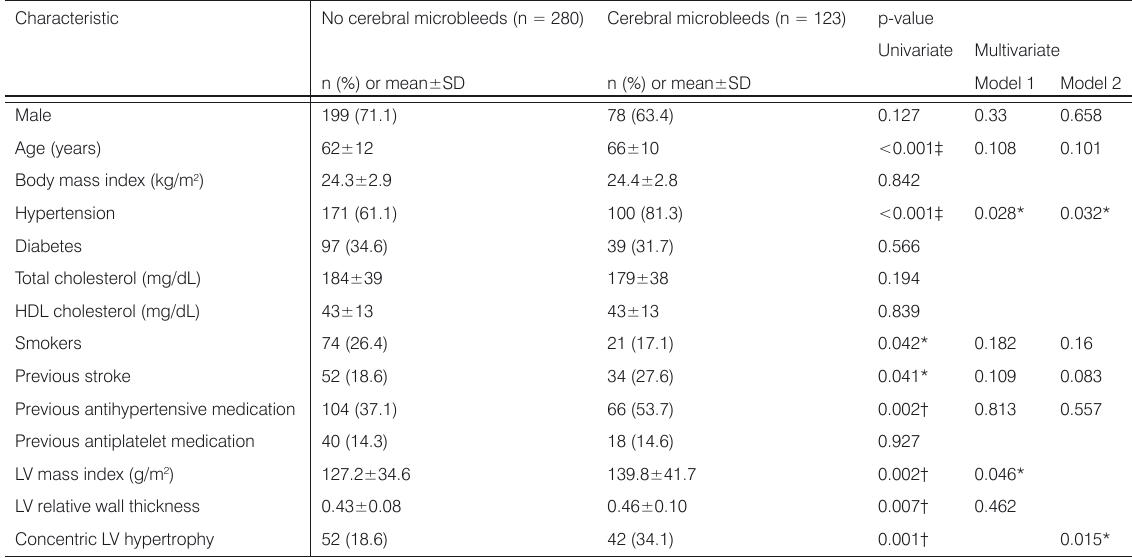
Table 3. Clinical characteristics of 403 patients according to the presence of cerebral microbleeds.